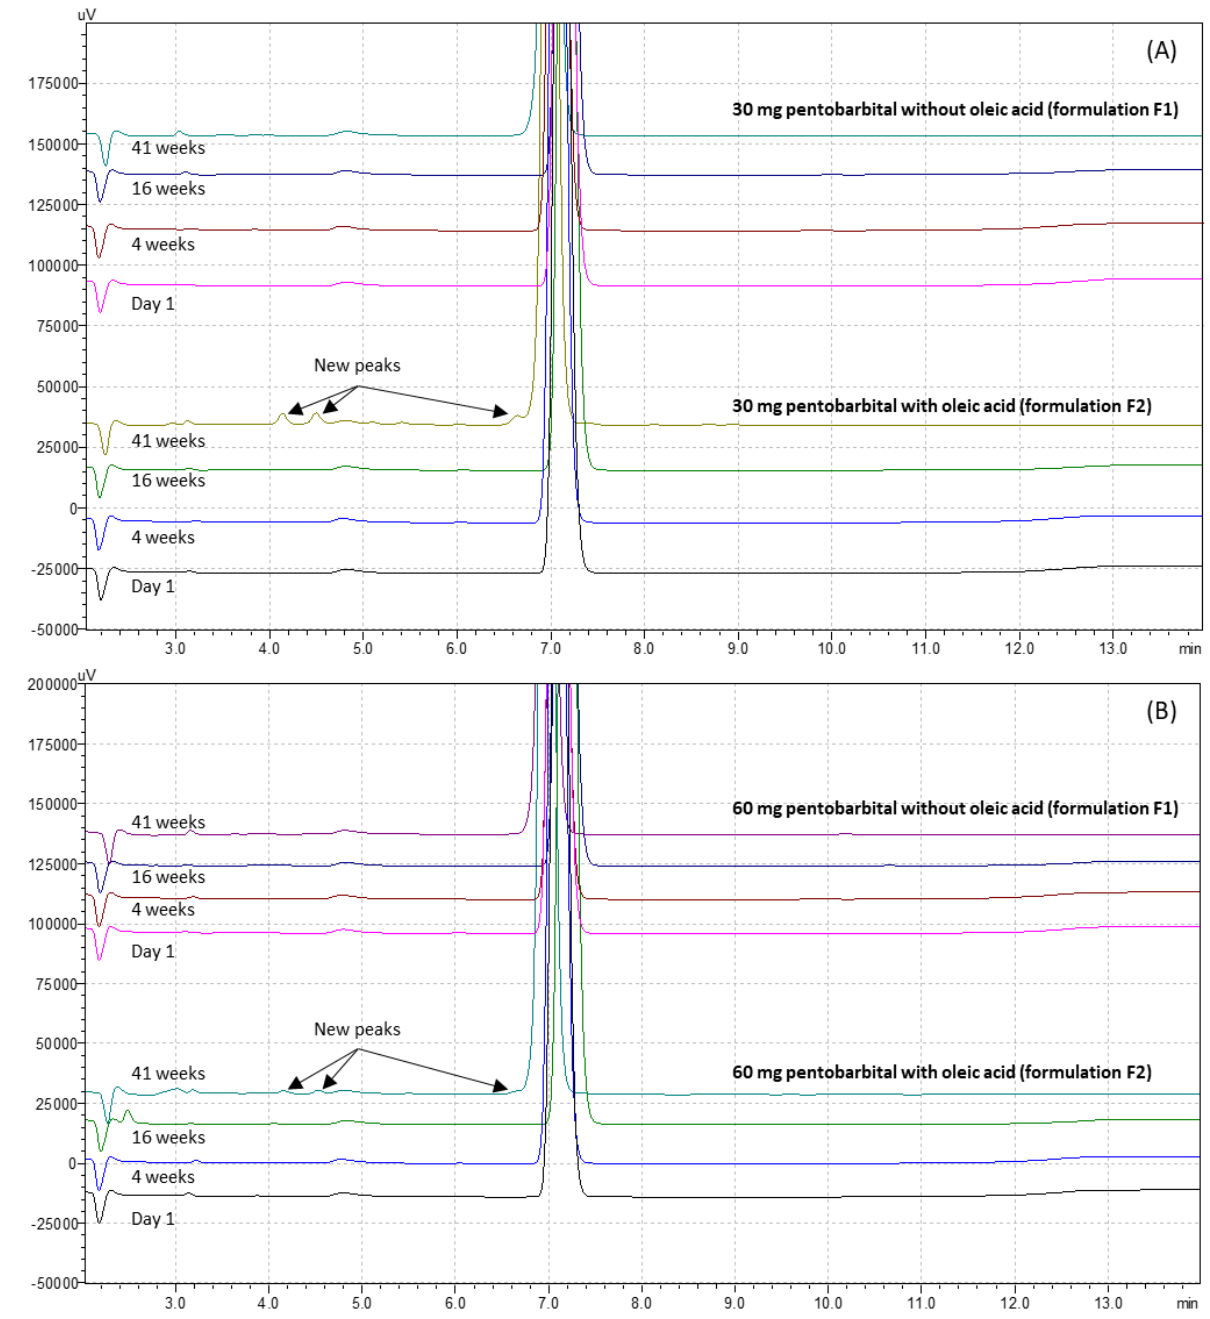
Figure 5. Example of pentobarbital chromatograms after storage, for ( A ) 30 mg pentobarbital suppositories and ( B ) 60 mg pentobarbital suppositories, for both studied formulations.